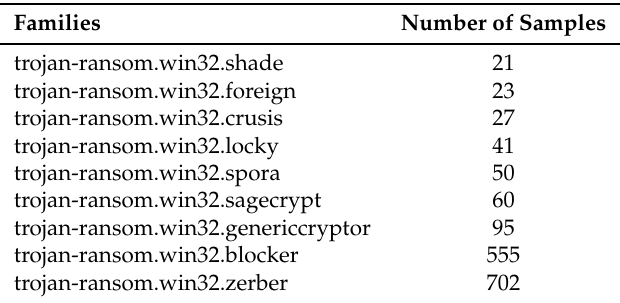
Table 1. Ransomware families of the FFRI 2017